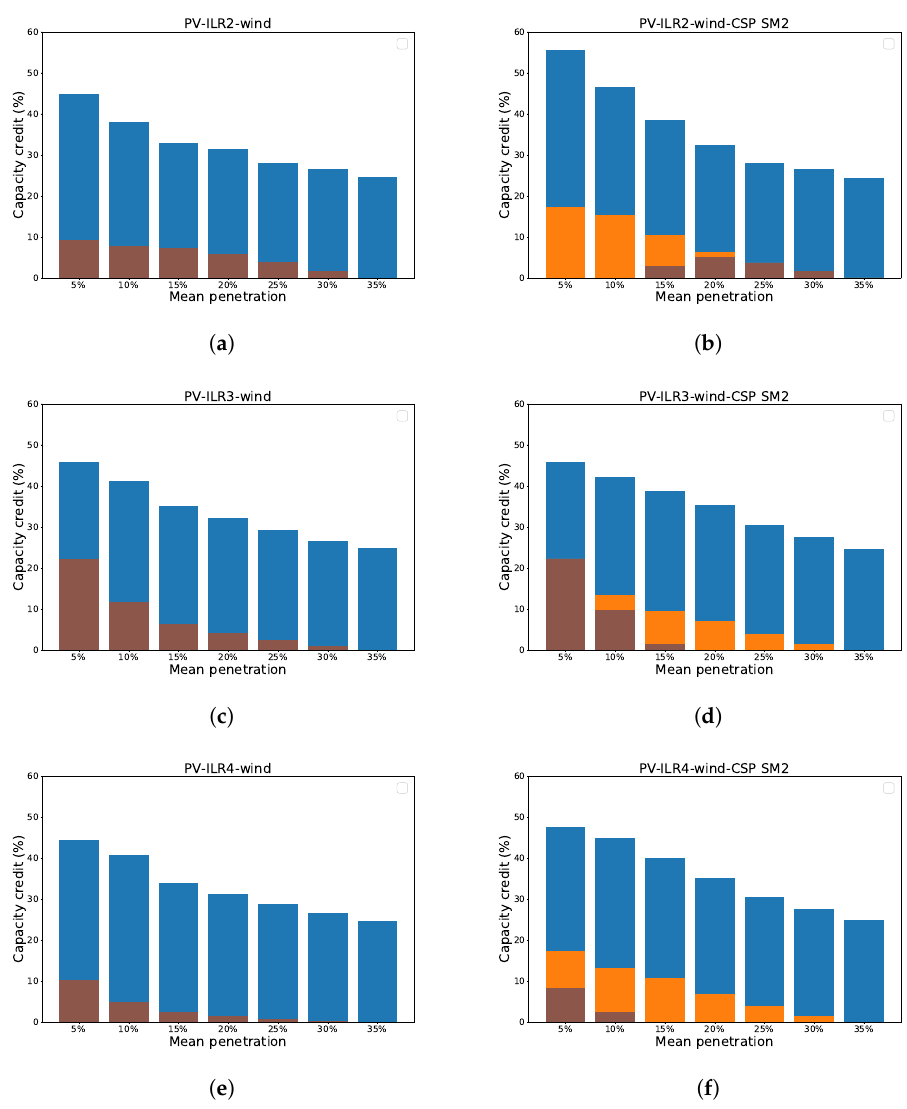
Figure 9. Capacity credit by each technology—Wind (blue), PV-BES (brown) and CSP-TES (orange)— versus the mean penetration (1), µ , for the global strategy (2) with maximum-cost constraint (5). ( Left ) PV-BES-wind mix; ( Right ) PV-BES-wind-CSP-TES SM2 mix. ( Top ) ILR2; ( Middle ) ILR3; ( Bottom )